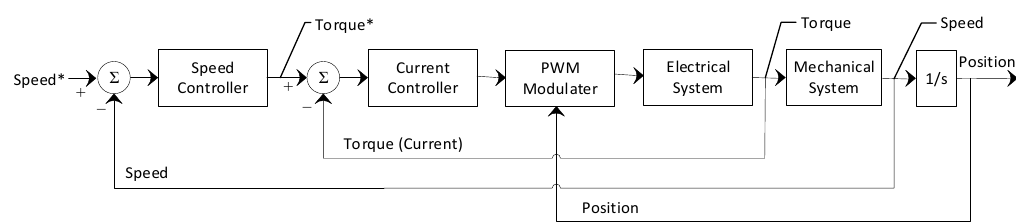
Figure 3. General cascaded proportional-integral (PI) control structure of an electric motor drive.